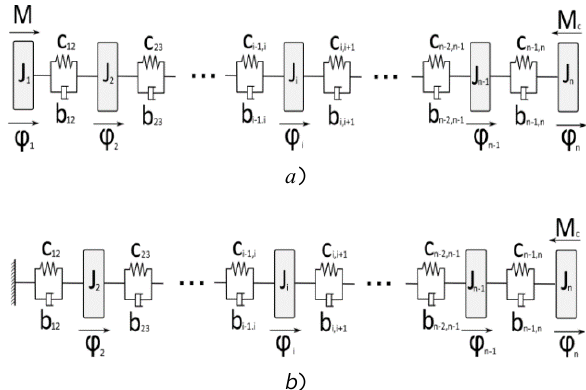
of inertia of the rotating is equivalent moment components of the mechanism, J n of inertia of the translational component (table), are angles of twist of the drive elements at the points of location of the corresponding reduced masses. Equivalent moments caused by elastic deformations and internal friction in the drive elements between the reduced masses are given by expressions of the form:  , where c and b are torsional stiffness and damping factor of i , k i , k ( s ) are the respective part of the mechanism, M ( s ) and M c torques of the motor and the resistance forces.